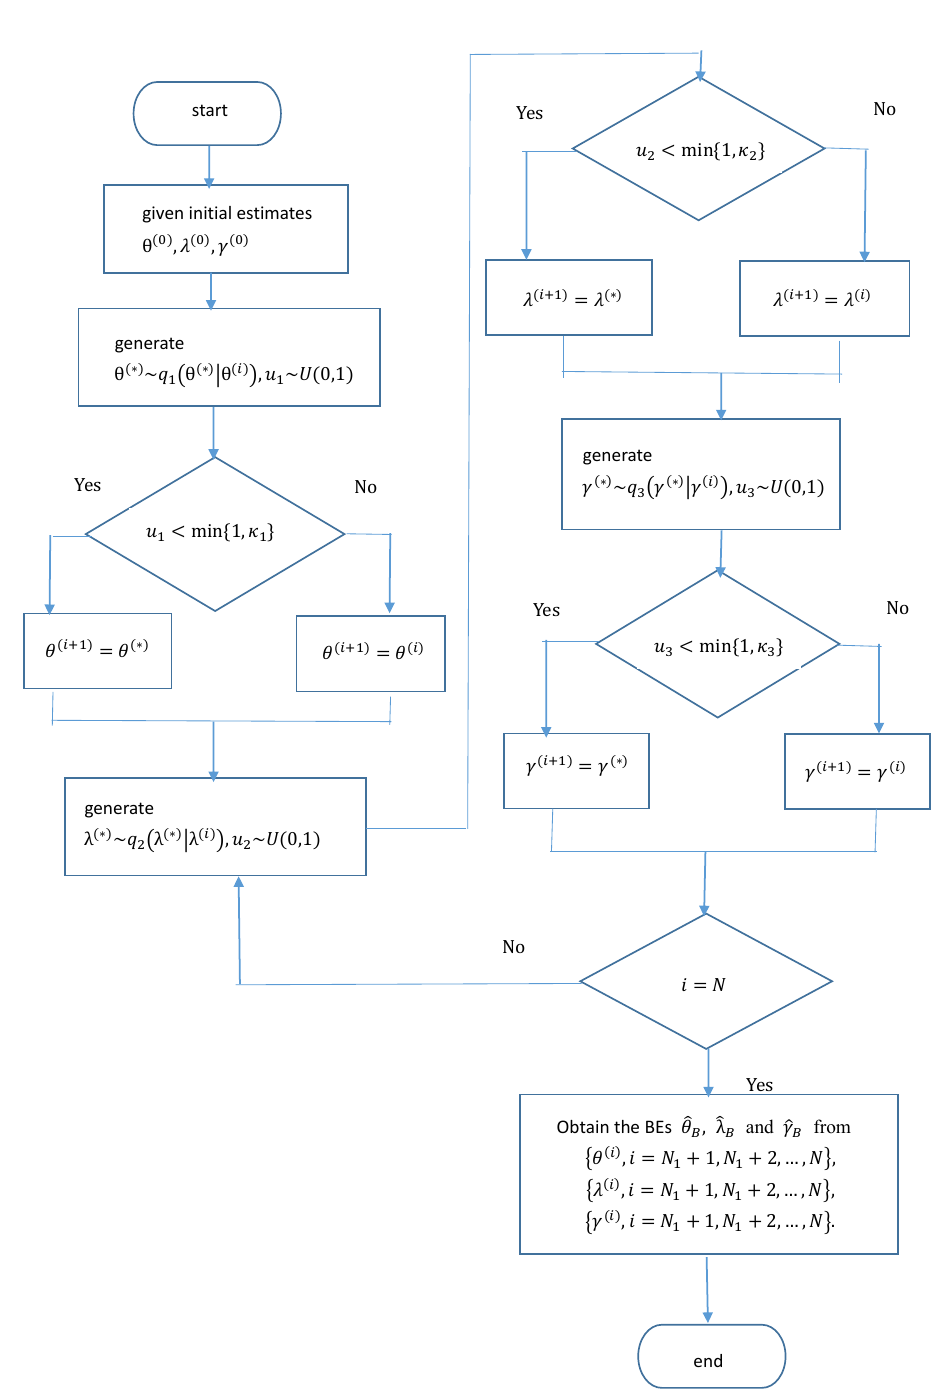
Figure 2. The flowchart of Procedure